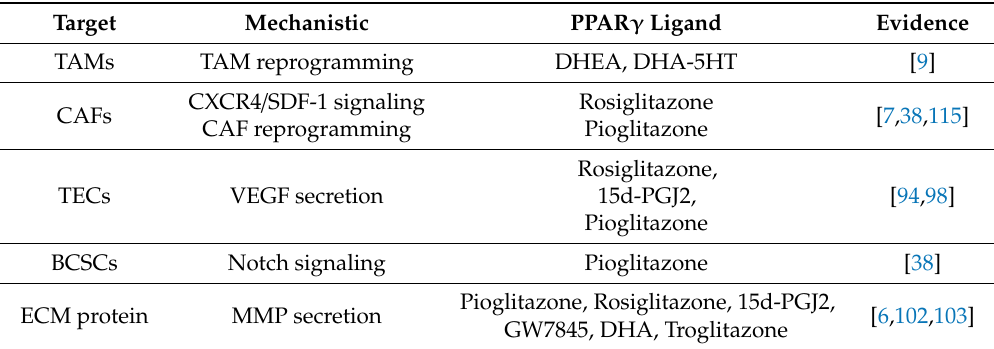
Table 2. Microenvironment components and the therapeutic potential of PPAR γ